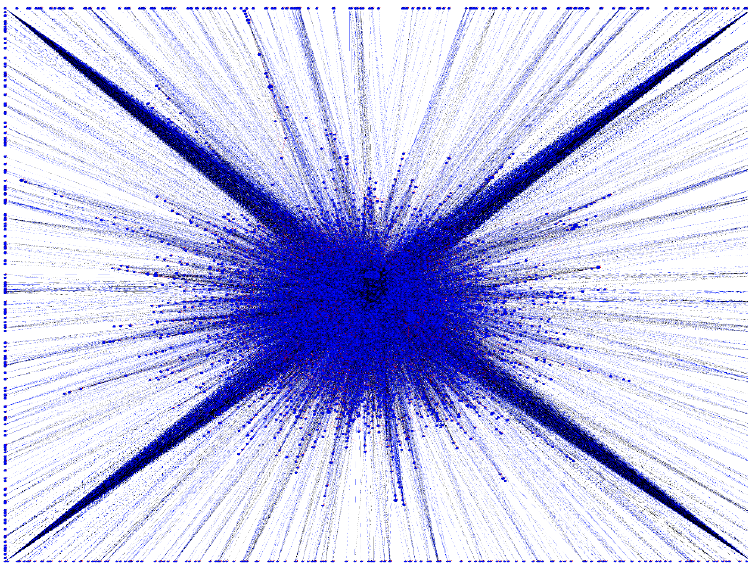
Figure 7. The Slashdot social network with 10,000 nodes (Network ‘A’).